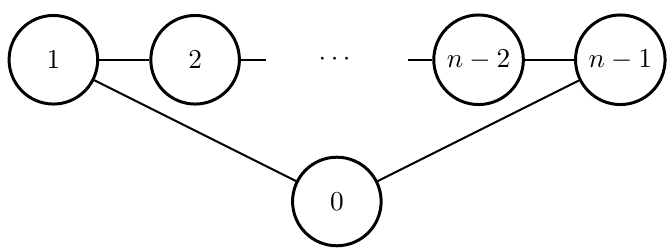
Figure 2. Dynkin diagram for su ( n ) . The numbers give the value of I corresponding to each node; the affine node has I = 0